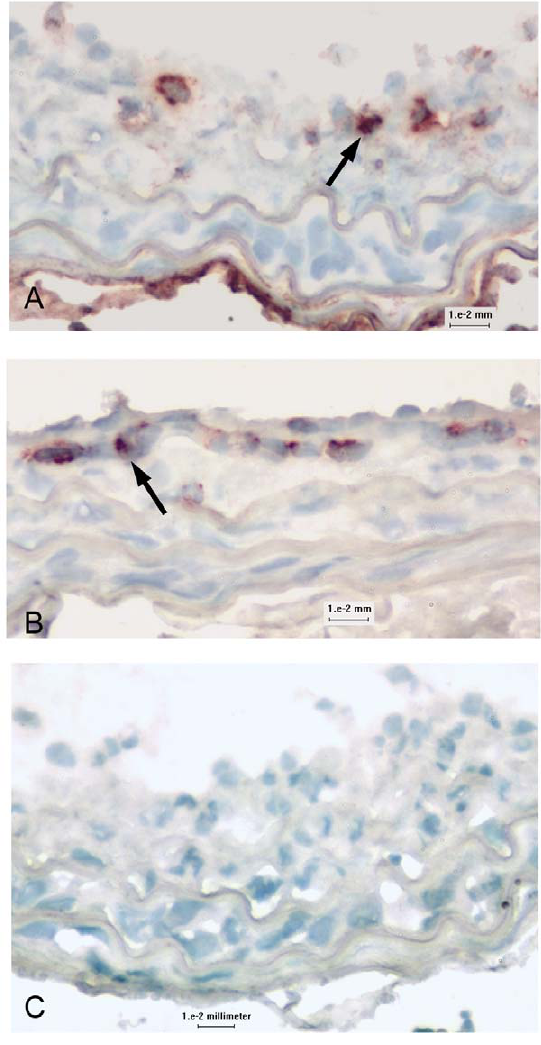
Figure 3. T cells in the injured arterial wall. Representative sections of 21-day injured carotid arteries stained for CD4 (A) or CD8b (B) identify their localization (arrows) in the arterial wall. Omission of primary antibody (C) was used as control for staining. N=4 each; bar=10 microns.